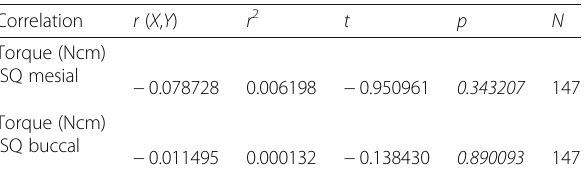
Table 3 The correlation of insertion torque to ISQ showed no statistical significance